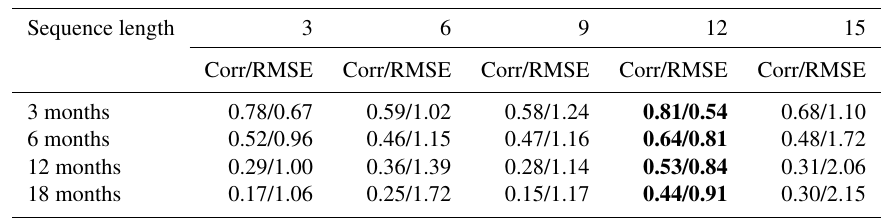
Table 1. Correlation skill (Corr) and root mean square error (RMSE) of lead times with different input sequence lengths. Bold values are the best of the five input sequence lengths.